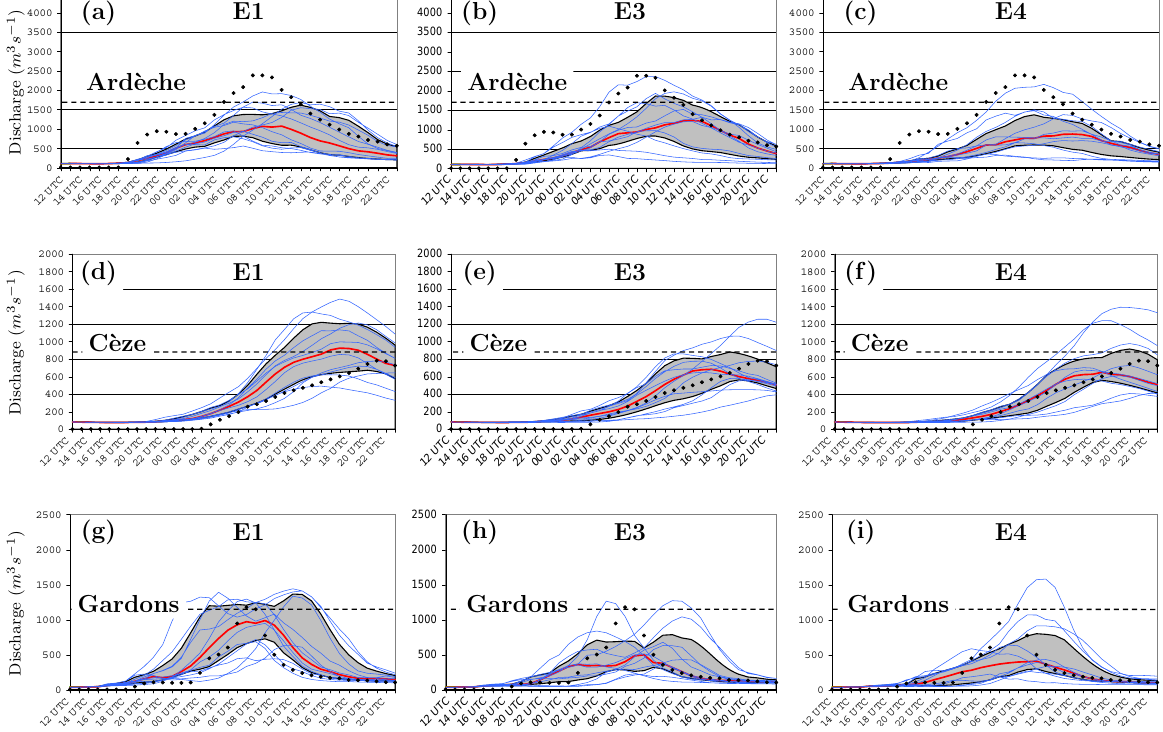
Fig. 14. Same as Fig. 13, for (a–c) the Ard`eche, (d–f) the C´eze and (g–i) the Gardons rivers, for Case 2, from 12:00 UTC 21 October 2008 to 00:00 UTC 23 October 2008, for the (a,d,g) E1, (b,e,h) E3 and (c,f,i) E4